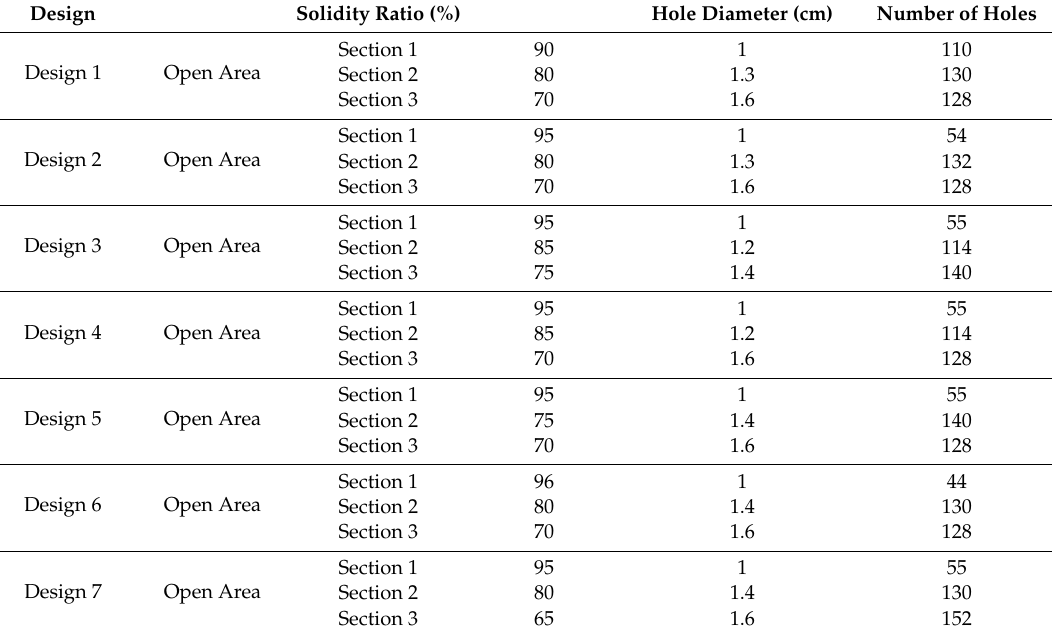
Table 2. Perforation parameters of ba ffl e designs with varying open